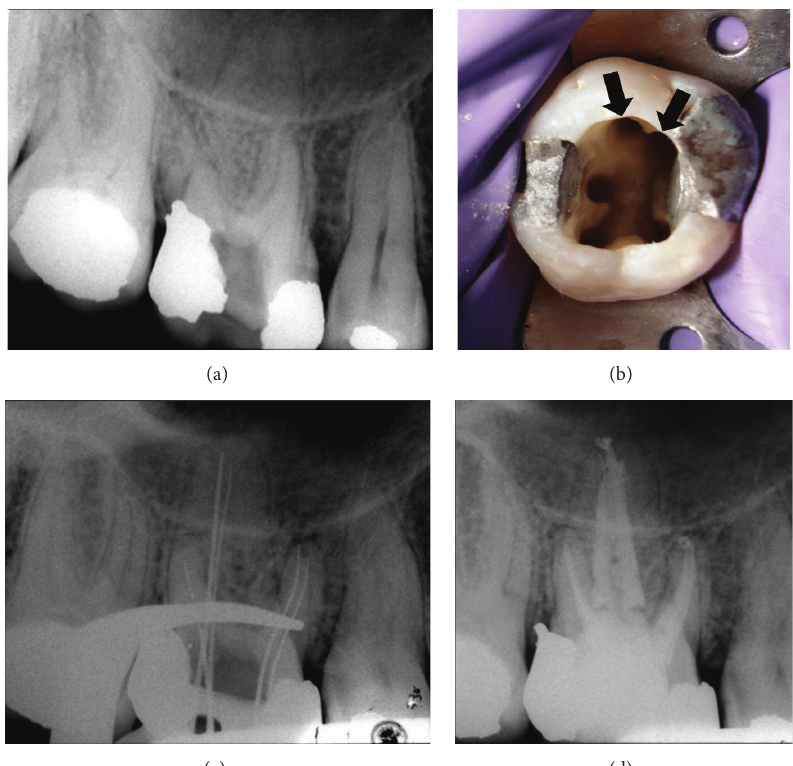
Figure 1: (a) Initial radiographic aspect of tooth number 3. (b) Endodontic access showing the presence of five root canal entrances. (c) Radiograph for working length determination. (d) Radiographic aspect after root canal